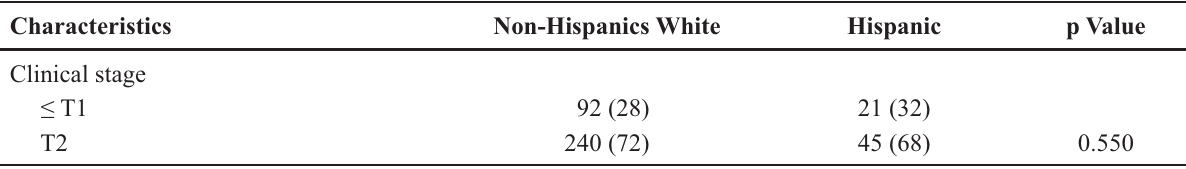
Table 2 – T stage before Radical Cystectomy in Hispanic and non-Hispanic white patients.